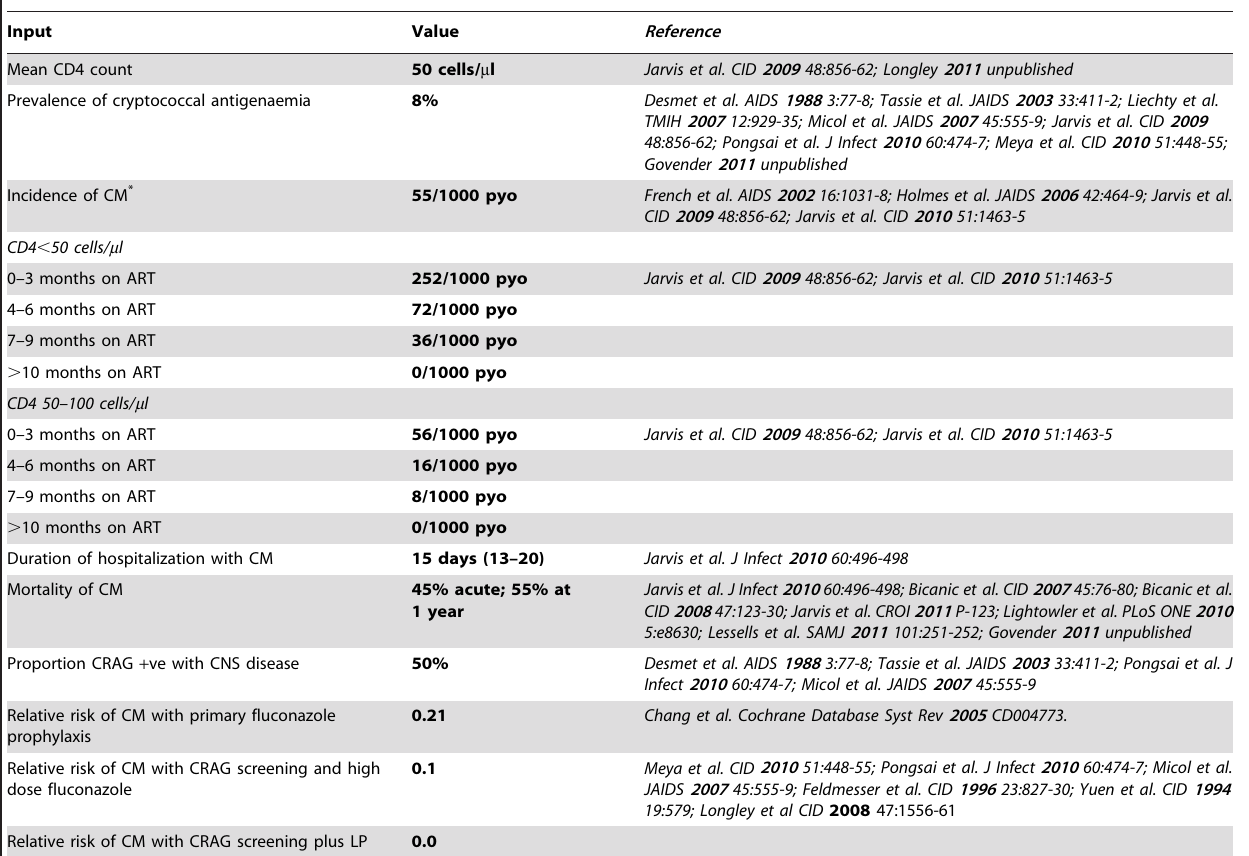
Table 1. Baseline input assumptions and transition